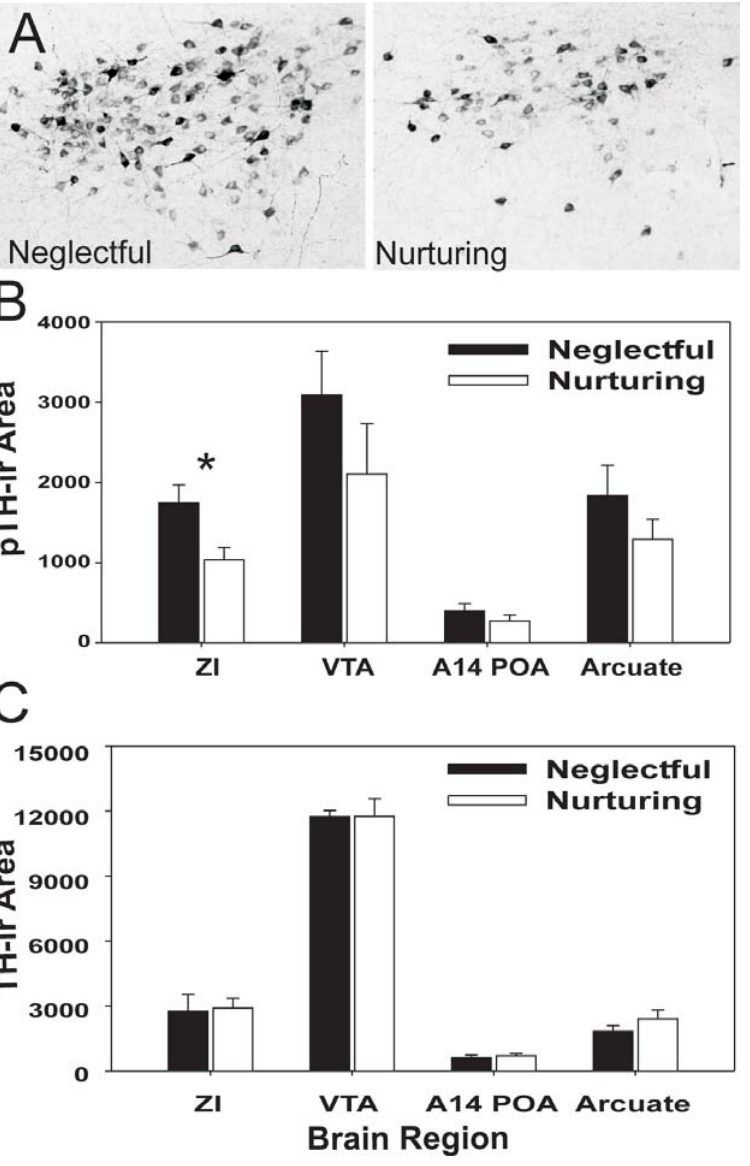
Figure 6. Altered pTH expression with maternal neglect. Example of heightened pTH immunoreactivity in ZI in neglectful relative to nurturing mice is shown in (A). Significant elevations of pTH-ir area are found in ZI, but not other dopamine producing regions, in neglectful mice (N=7) in comparison to nurturing dams (8) (B). TH-ir area does not differ between neglectful (N=8) and nurturing (N=8) mice. ZI=zona incerta, VTA=ventral tegmental area, A14 POA=A14 region of preoptic area. Bars represent means 6 SE. * =p ,